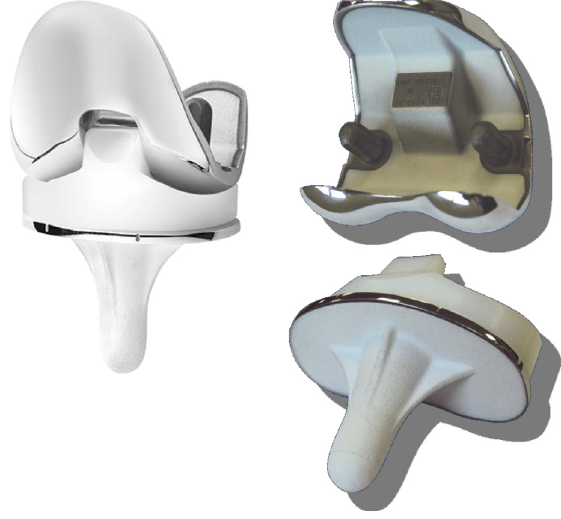
Figure 1. New Wave TKA TM implant design, HA coating in cementless